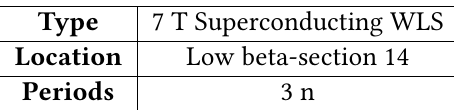
Table 1: Parameters of the